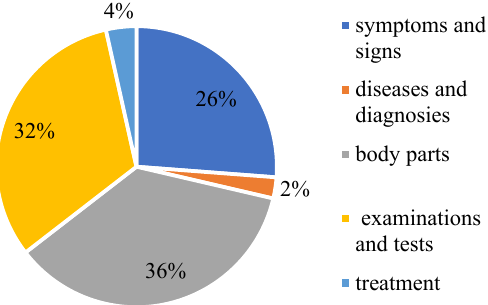
Figure 11. The proportion of medical entities on CCKS2019.